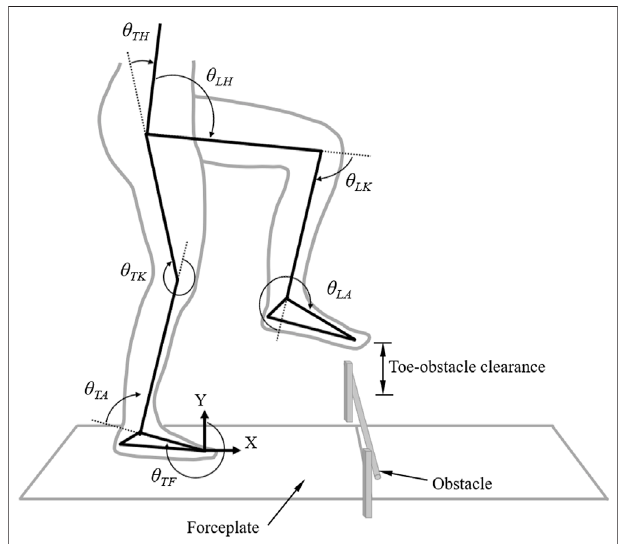
FIGURE 2 | The planar seven-link model of the body when obstacle- crossing.Twoforceplatesareplacedoneithersideoftheobstacle.De fi nitions of the toe-obstacle clearance and the joint angles are also indicated: hip ( θ LH ), knee ( θ LK ) and ankle ( θ LA ) of the leading swing limb, and foot ( θ TF ), ankle ( θ TA ), knee ( θ TK ) and hip ( θ TH ) of the trailing stance limb. The upper body, namely the segments of the head/neck, trunk, pelvis, and upper extremities, wasmodeledasasinglelink,de fi nedasthelineconnectingthehipjointcenter and the center of mass of all the upper body segments. The hip angles were de fi ned as the angles between the upper body link and the thigh links. The X-axis indicates the direction of progression.